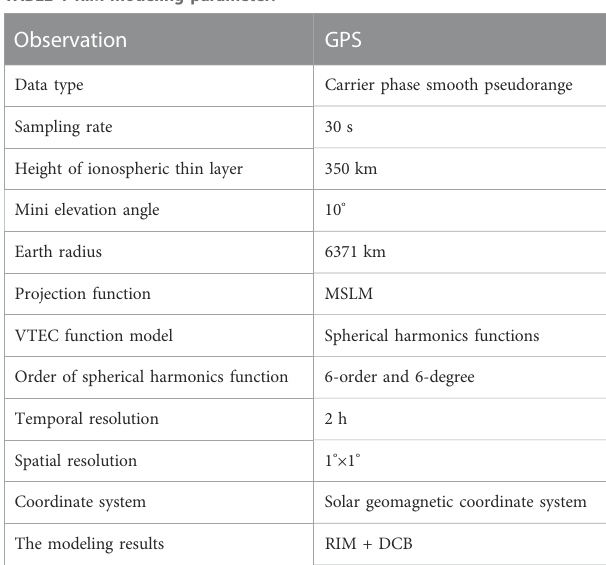
TABLE 1 RIM modeling parameter.